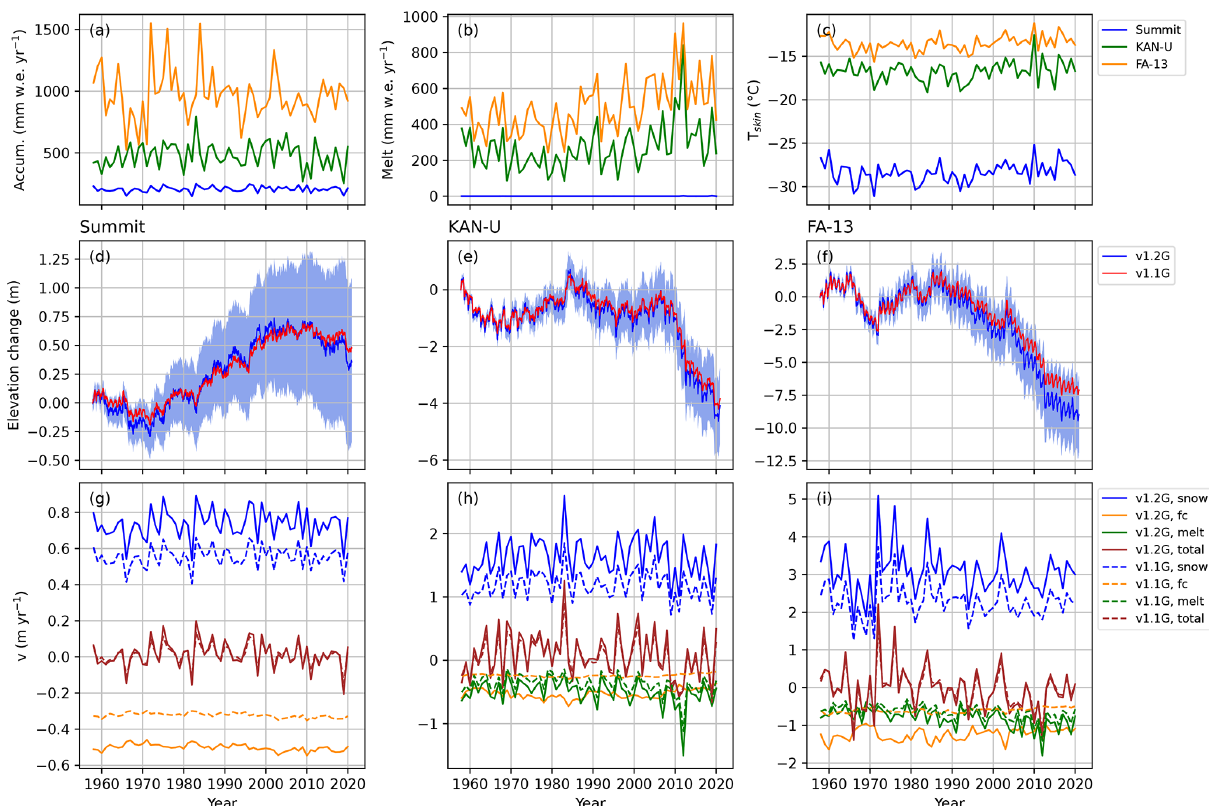
Figure 10. Time series of the total annual accumulation (a) , total annual melt (b) and the annual mean skin temperature (c) at Summit, KAN- U and FA-13. Panels (d) – (f) show the net cumulative surface elevation change since the start of the simulation for these three locations. The blue area indicates the uncertainty in the v1.2G results. Finally, panels (g) – (j) show the mean annual velocity components that cause the elevation